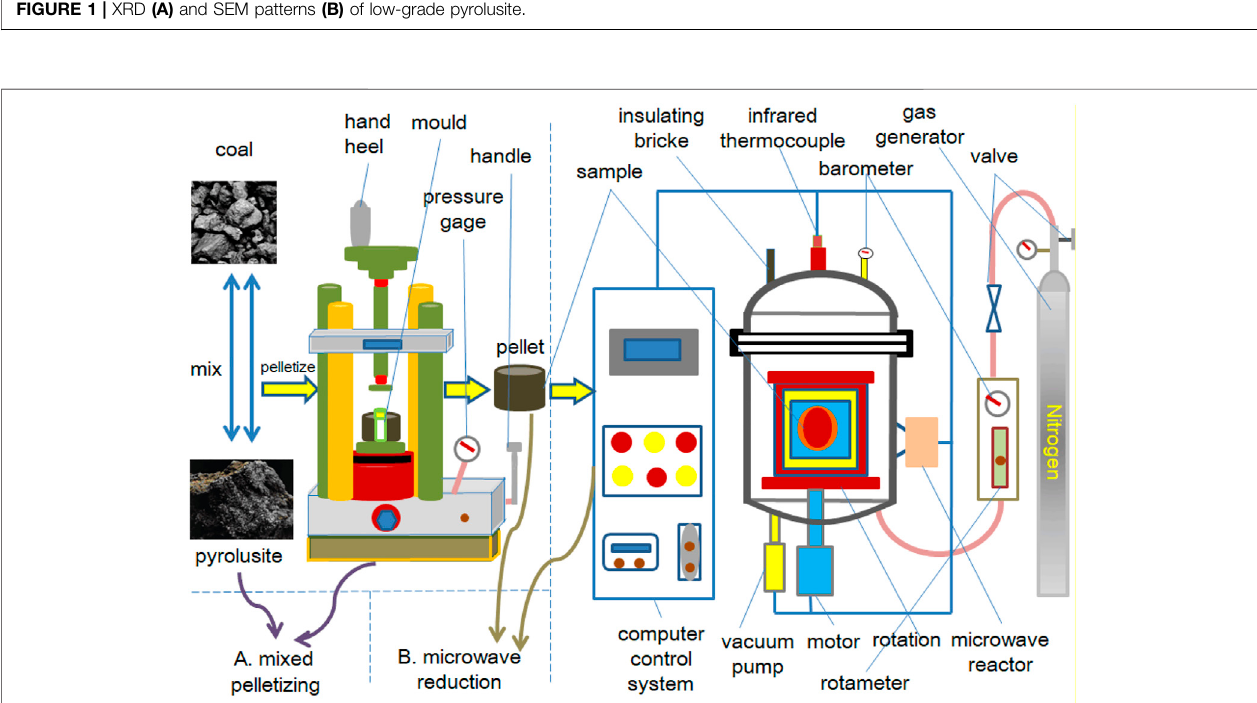
FIGURE 2 | Flow chart of microwave carbothermal reduction of low-grade pyrolusite.